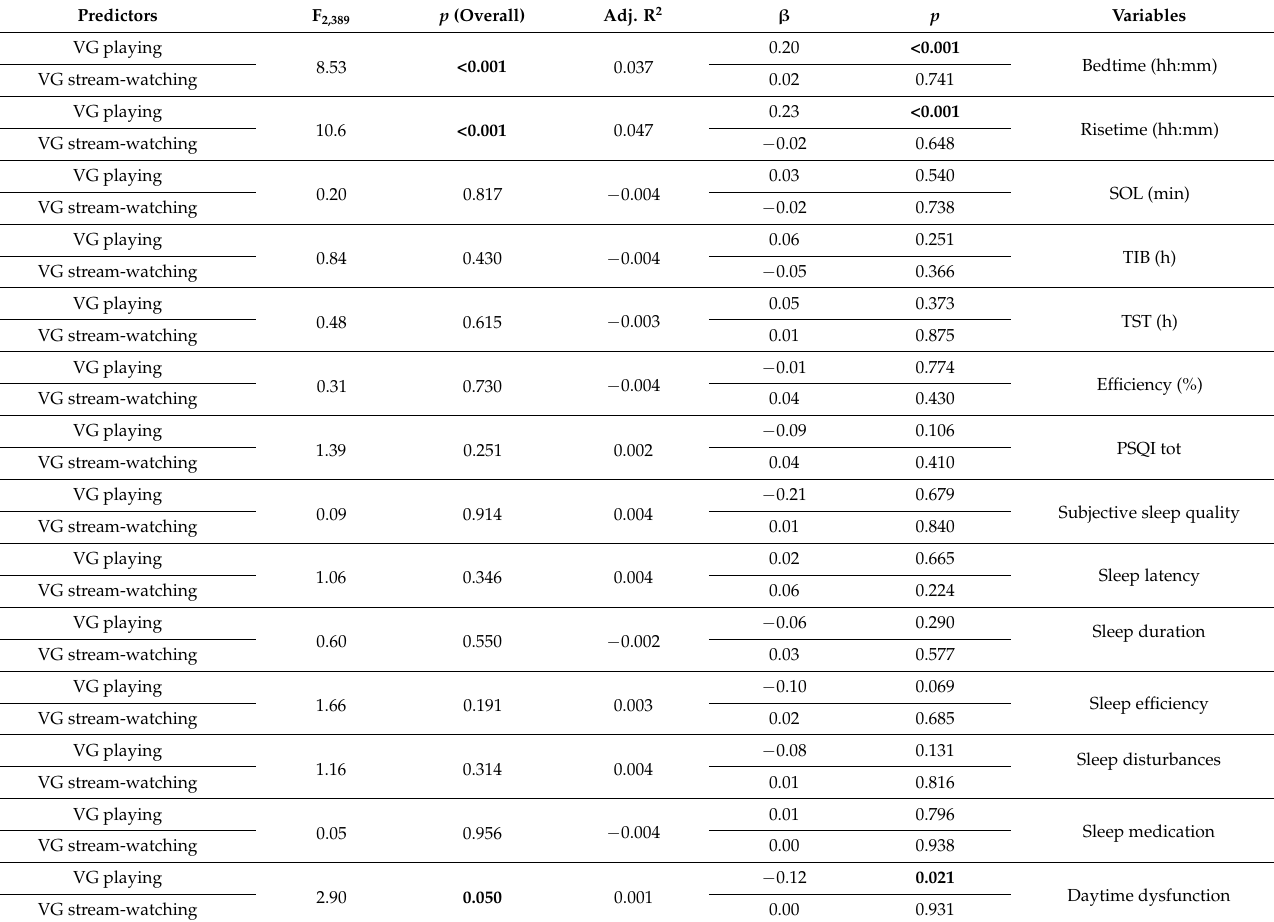
Table 3. Linear regression results for sleep variables and PSQI scores.